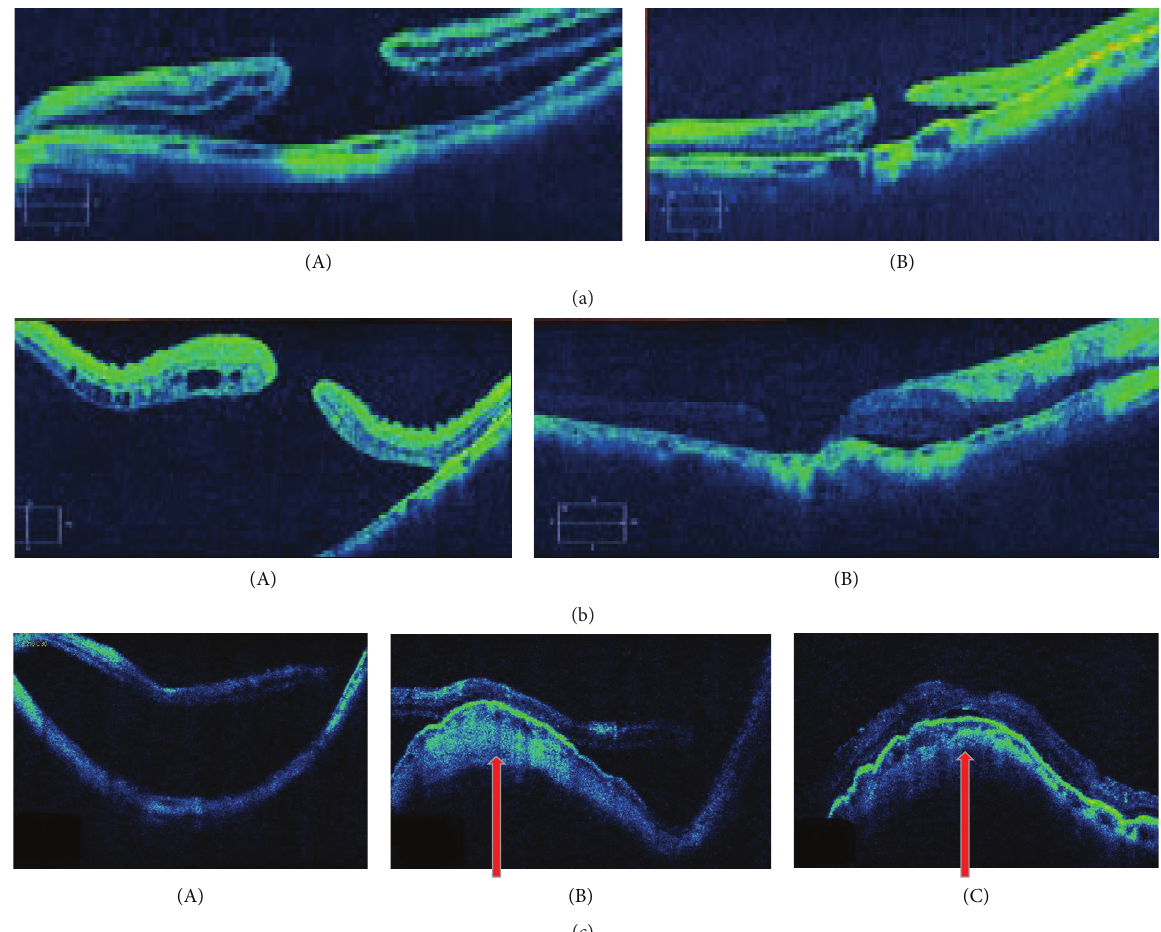
Figure 2: Upper pictures for OCT (a). (A) Before fiber optic guided macula buckling. (B) Three weeks after surgery, showing complete reattachment but with persistently opened hole. Middle OCT cuts (b). (A) An eye with MHRD three days before the procedure. (B) One week after fiber optic guided EMB showing complete reattachment and reapposition of the hole edge on a horizontal OCT scan. Lower pictures (c). (A) OCT shows the subretinal fluid in a vertical cut not passing through the macular hole; (B) shows 1 week after EMB with reapposition of the macula; (C) residual fluid which disappeared 5 days later.